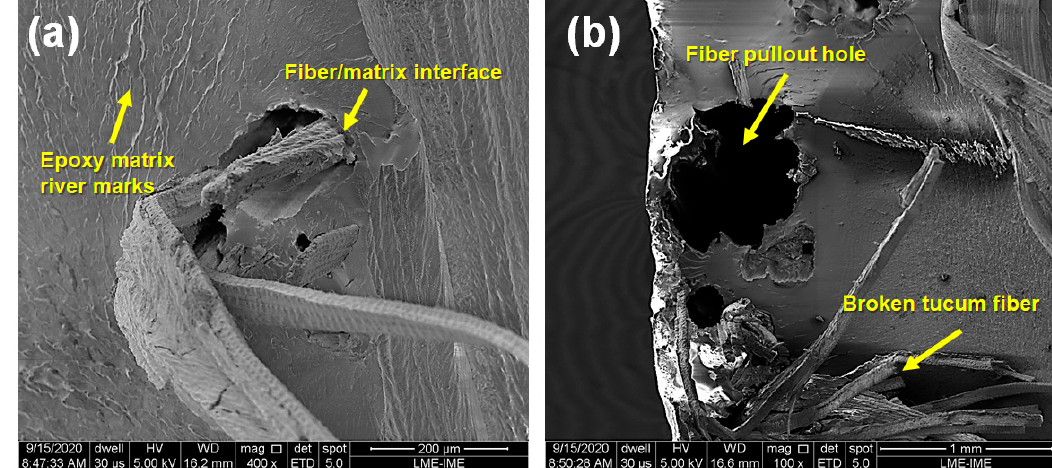
Figure 9. Composite with 40 vol% of tucum fiber with different magnifications: ( a ) 400× and ( b ) 100×.